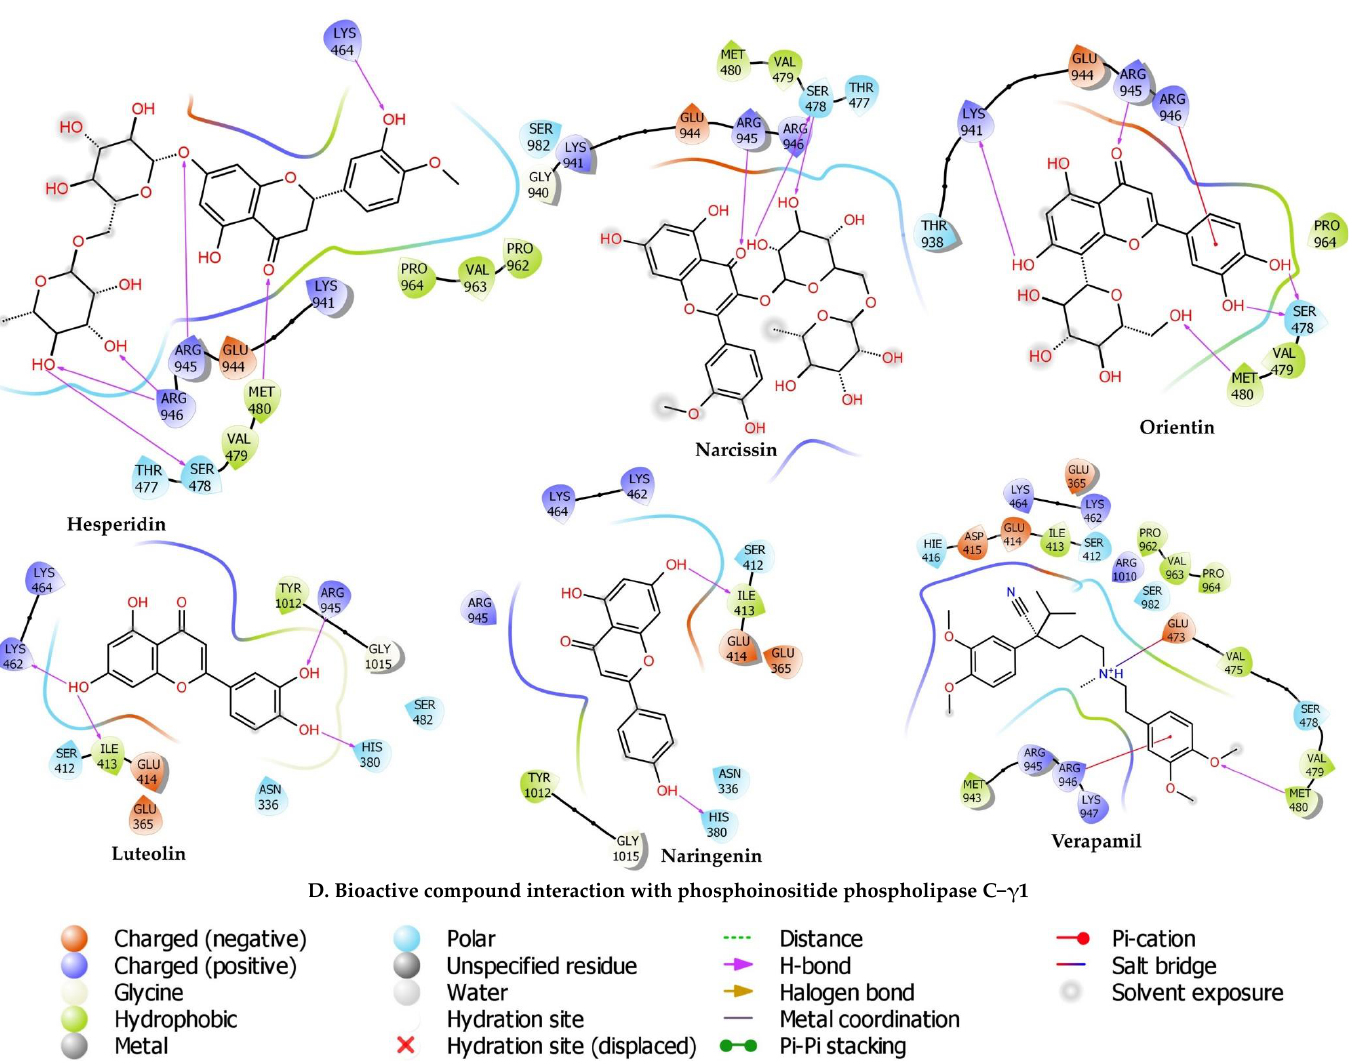
Figure 5. 2D protein–ligand interaction between bioactive compounds and proteins; ( A ) voltage–gated calcium channel; ( B ) muscarinic M3 receptor; ( C ) myosin light chain kinase; and ( D ) Phosphoinositide phospholipase C – gamma – 1.